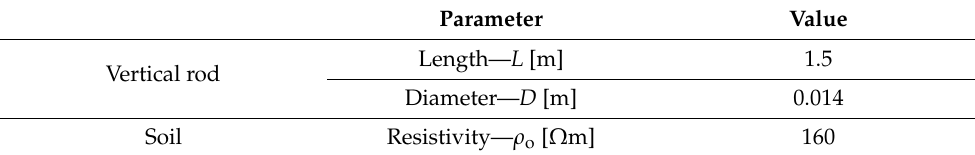
Table 1. Parameters of the electrode and soil for the vertical rod.